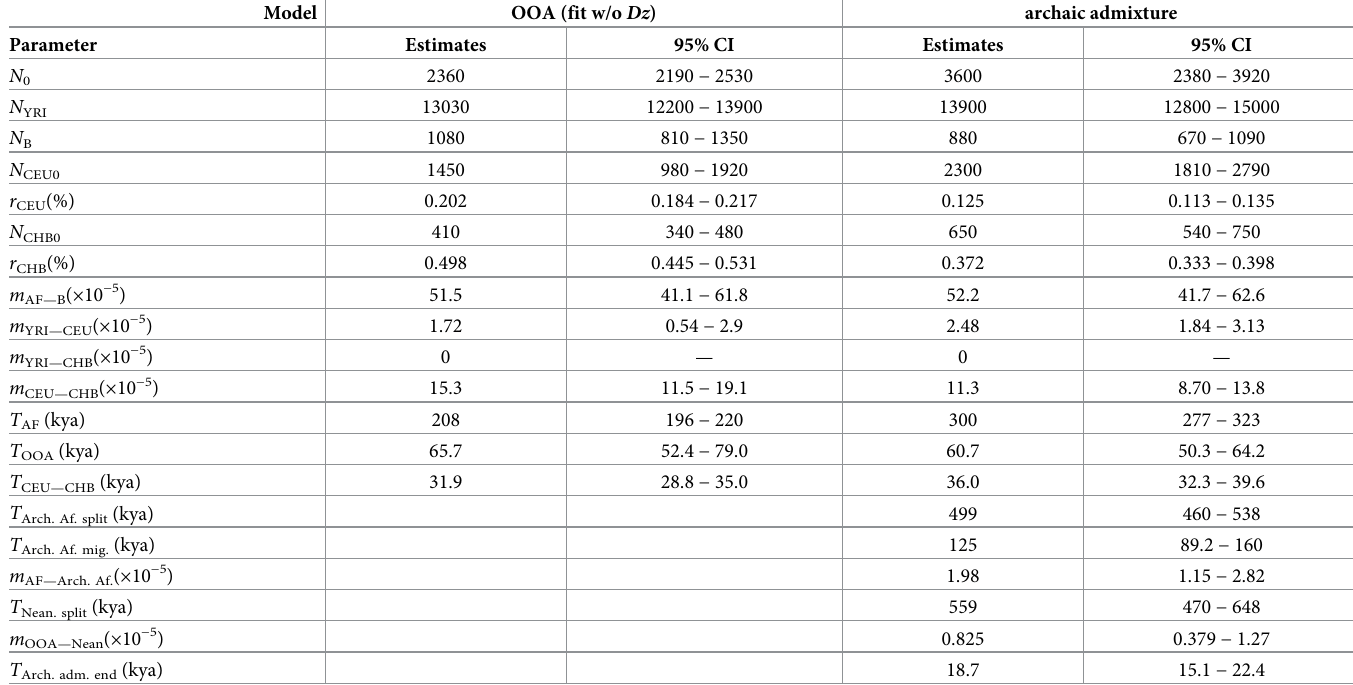
Table 1. Inferred parameters for OOA models. Two models for the out-of-Africa expansion. We fit the commonly used 13-parameter model to the multi-population Hill-Robertson statistics (left). The best fit parameters shown here were fit to the set of statistics without the E ½ Dz � terms, because the inclusion of those terms led to run- away parameter behavior in the optimization. This is often a sign of model mis-specification. On the right, the same 13-parameter model is augmented by the inclusion of two deeply diverged branches, putatively Neanderthal and an unknown lineage within Africa. We inferred that these branches split from the branch leading to modern humans roughly 460 − 650 kya, and contributed migrants until quite recently ( * 19 kya). Times reported here assume a generation time of 29 years and are calibrated by the recombination (rather than mutation) rate. Confidence intervals were computed using the Godambe information matrix on bootstrap replicates of the data